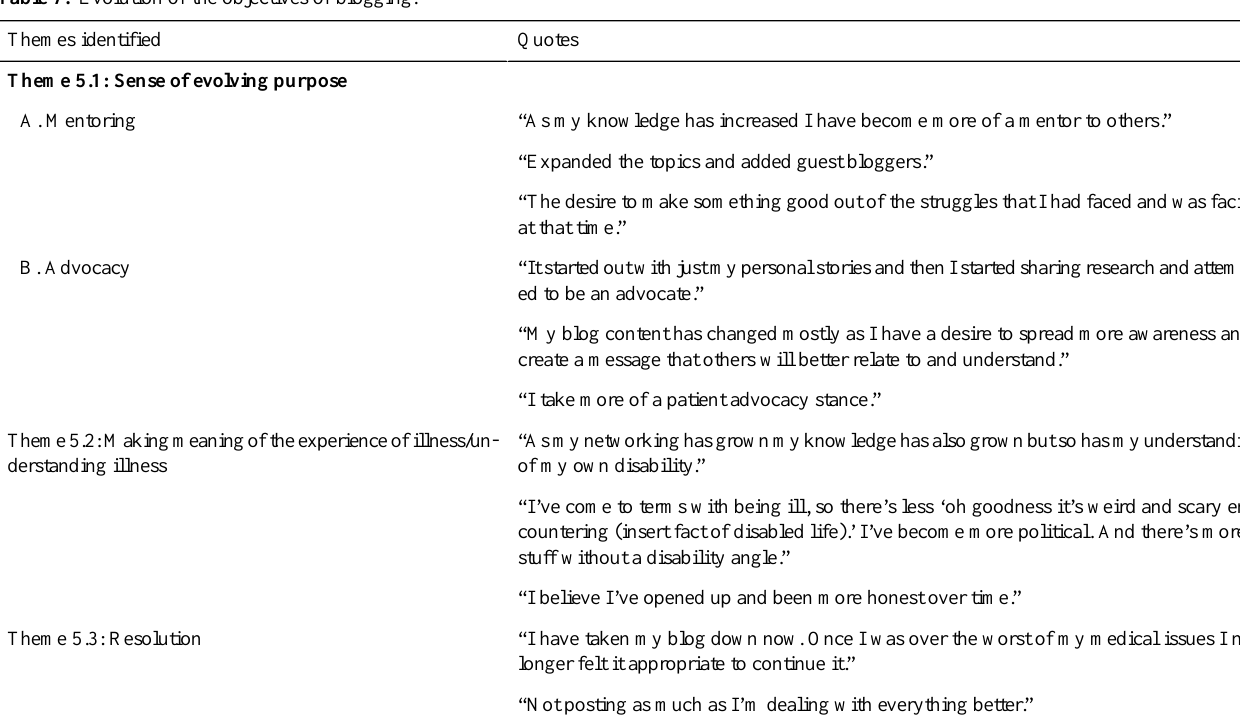
Table 7. Evolution of the objectives of